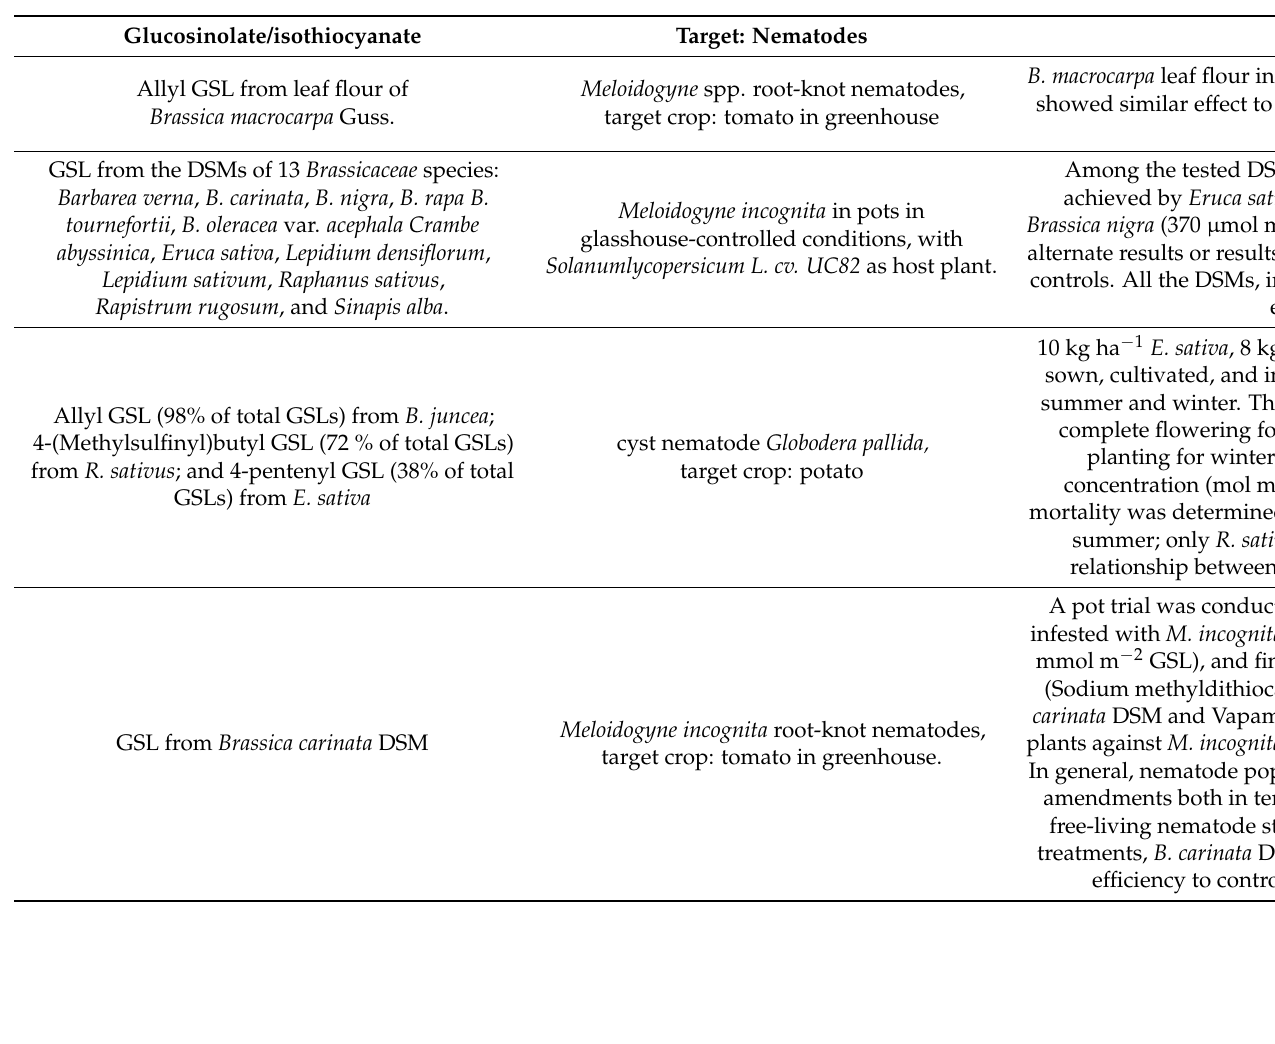
Table 2. Biofumigation in vitro, in pots, and in open-field trials published in the last 10 years with defined glucosinolate